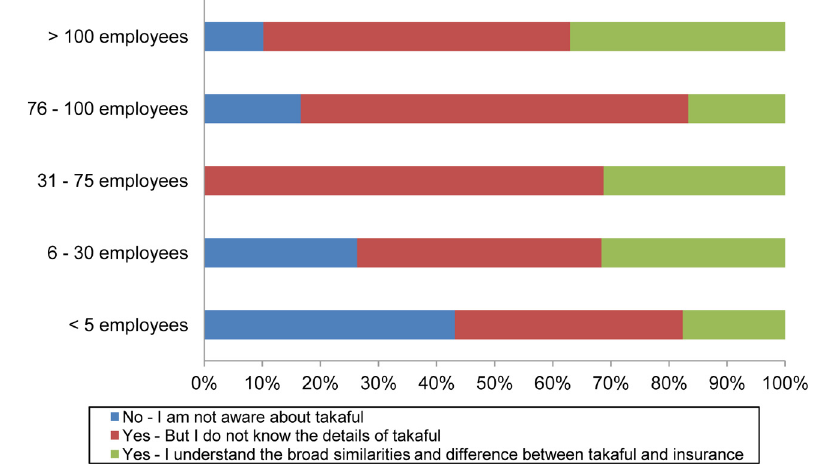
Figure 6. Composition of